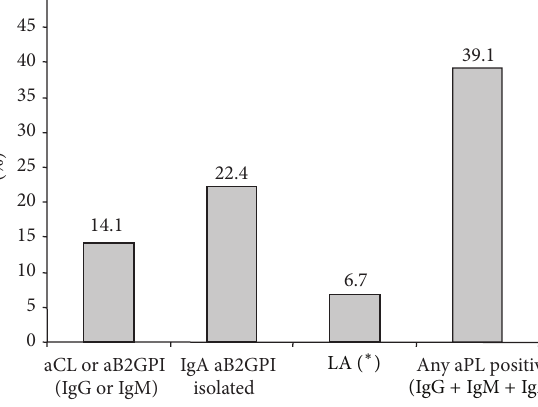
Figure 2: Percentage of C-APS patients positive for aPL antibodies. ( ∗ ) LA detection was performed on 90